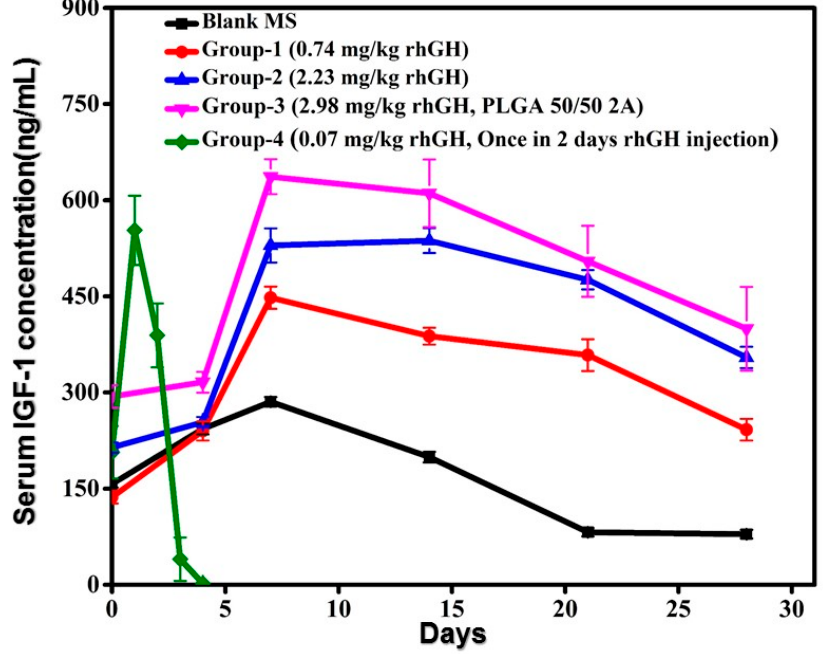
Figure 8. Serum concentration of IGF-I after single subcutaneous injection of different treatments ( n = 5, p < 0.05).